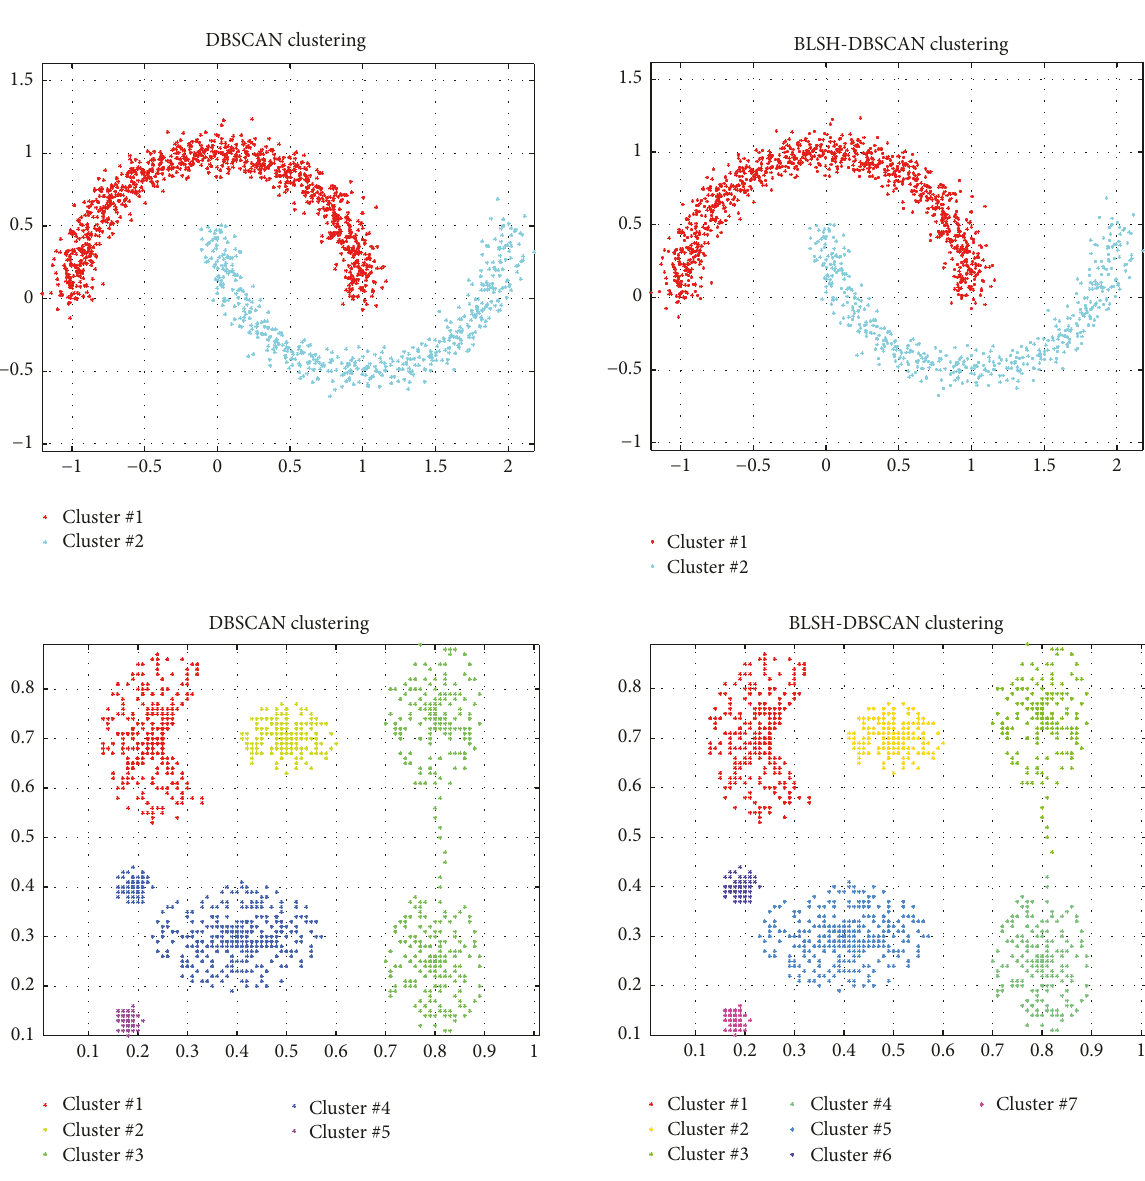
Figure 4: Best cluster results in different